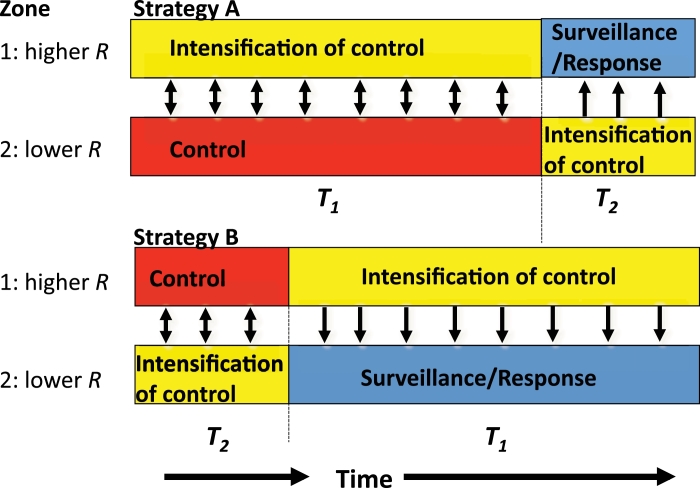
Strategies being compared. The black arrows indicate the direction of the export/import of infected cases. Here, R denotes the transmission potential and Ti denotes the duration of intensified measures needed to achieve elimination (Table 1).